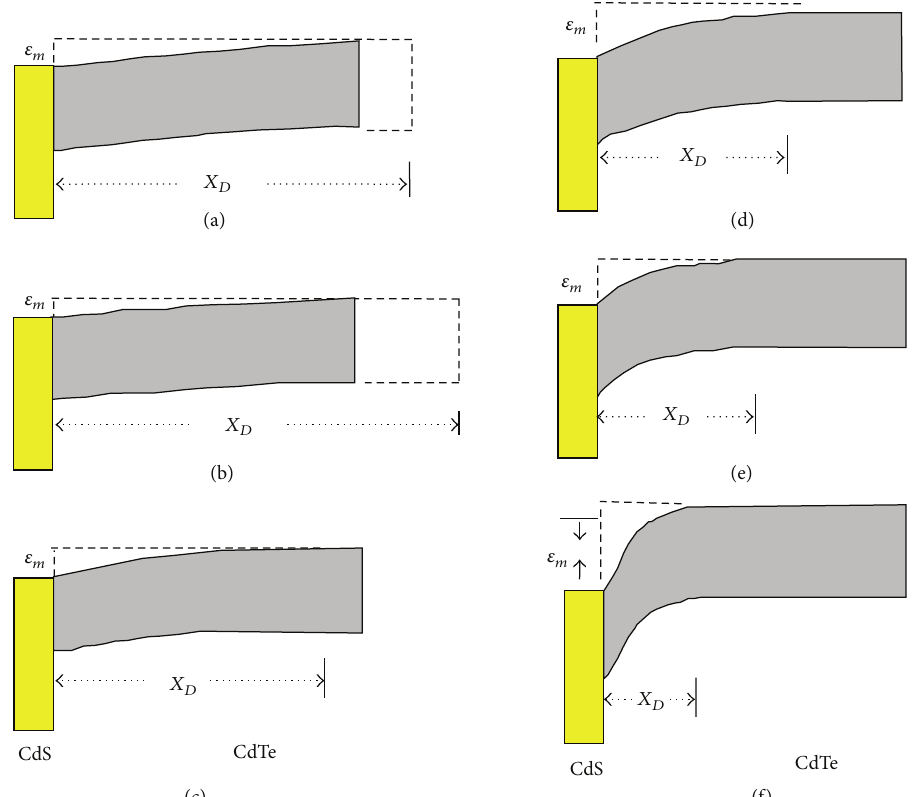
Figure 4: Schematic diagram of energy band for CdS/CdTe heterojunction. ((a)–(f)) Corresponding to samples 1–6,